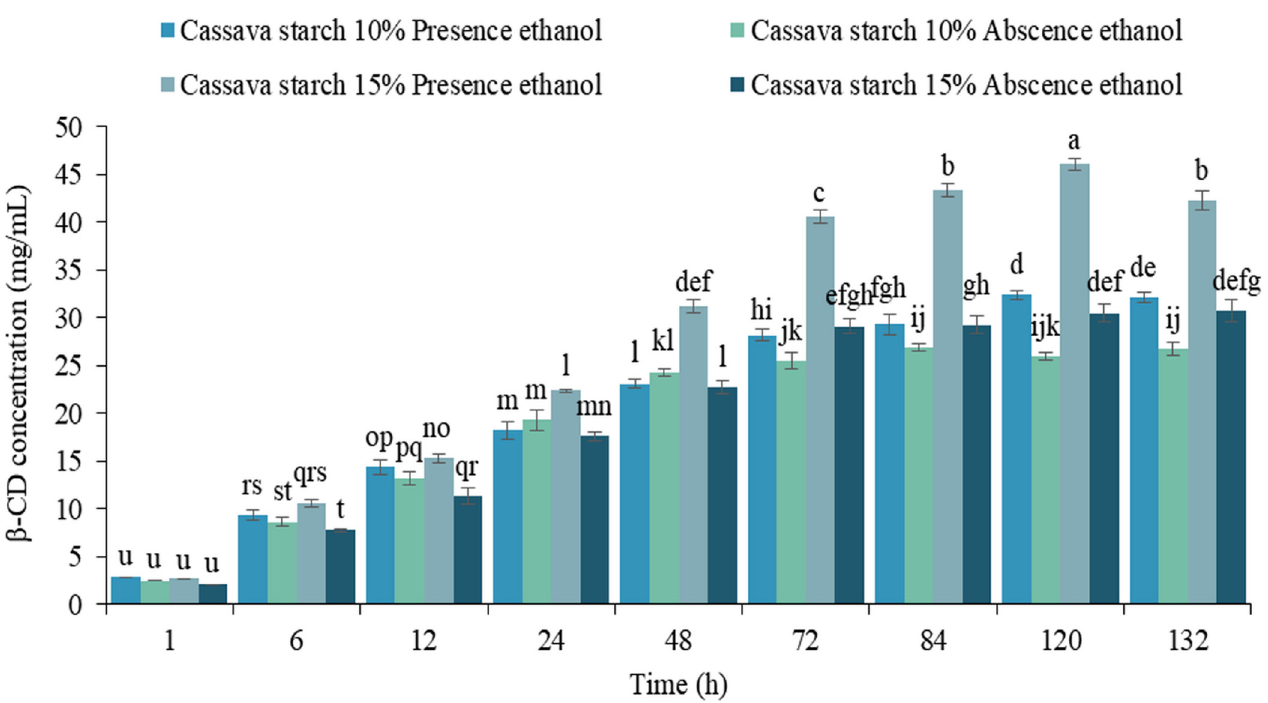
FIGURE 2 - β -CD production using 10 and 15% cassava starch (w/V) in the presence and absence of 10% ethanol (V/V) for 132 h. Spectrophotometric analysis using the phenolphthalein